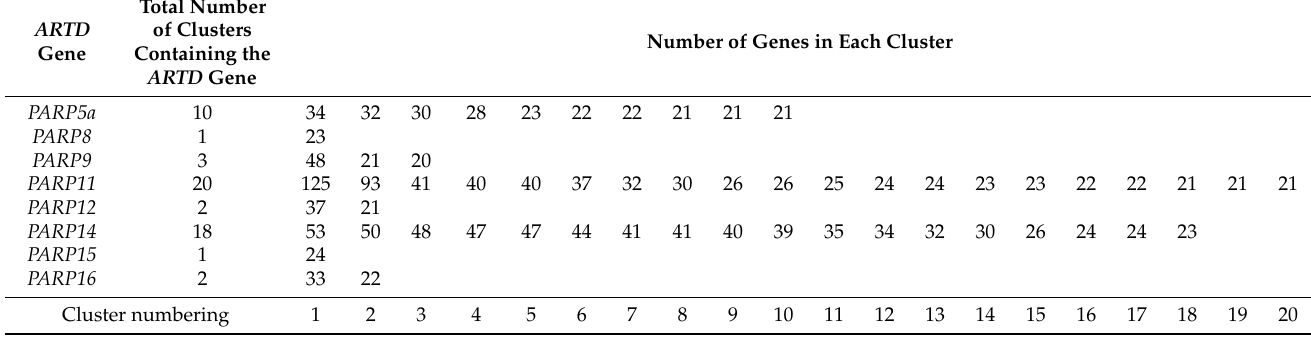
Table 2. Gene cluster database analysis for genes including PARPs